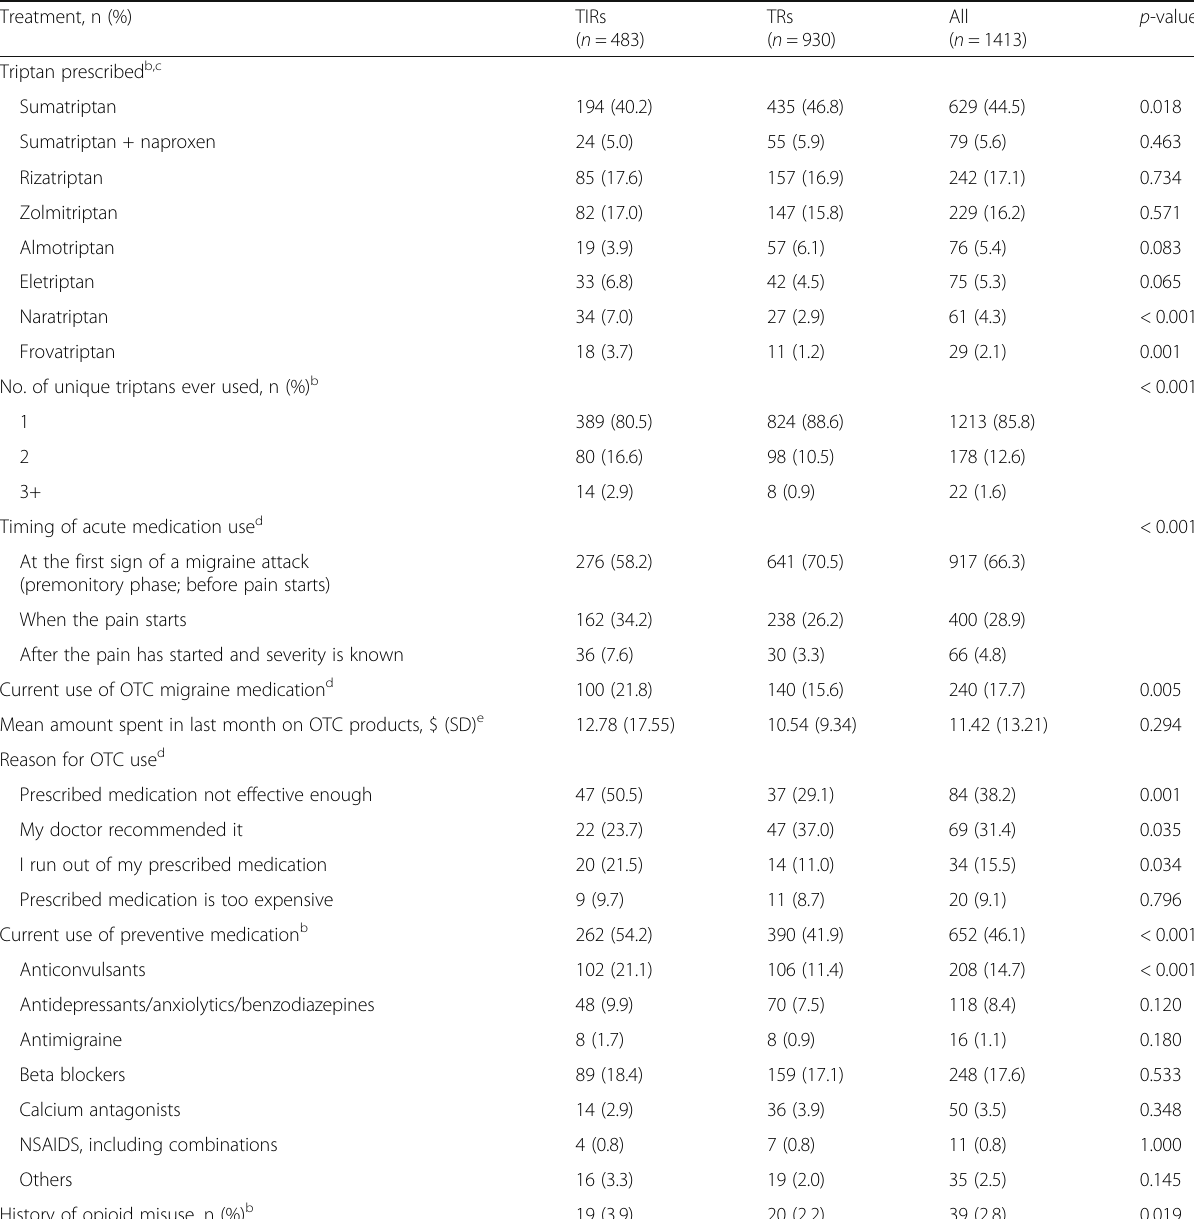
Table 3 Migraine treatment characteristics Treatment, n